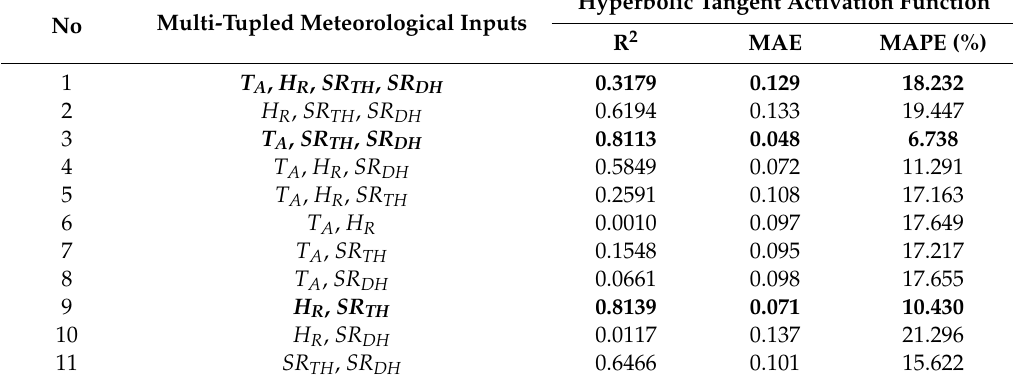
Table 4. Daily photovoltaic power prediction results of the ALO-MLP method, which used the hyperbolic tangent activation function.